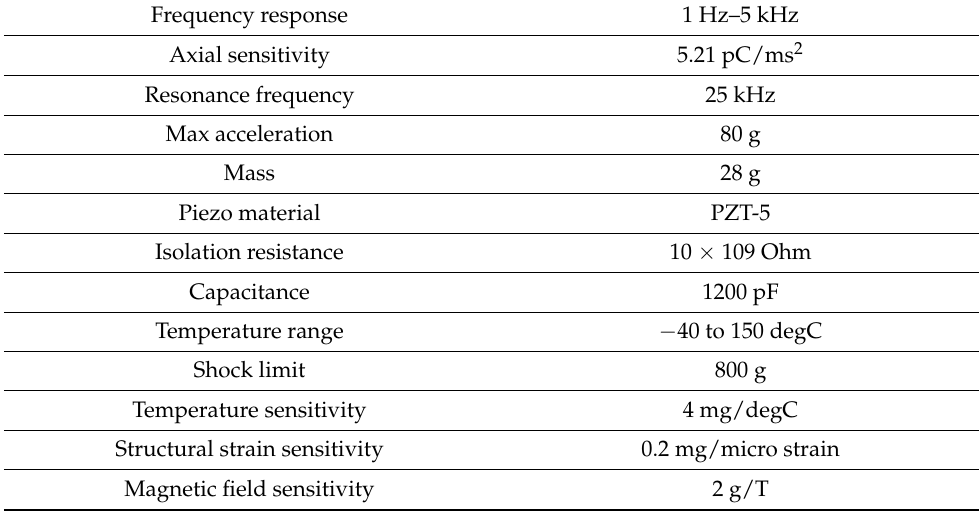
Table 2. KCF AG107M accelerometer